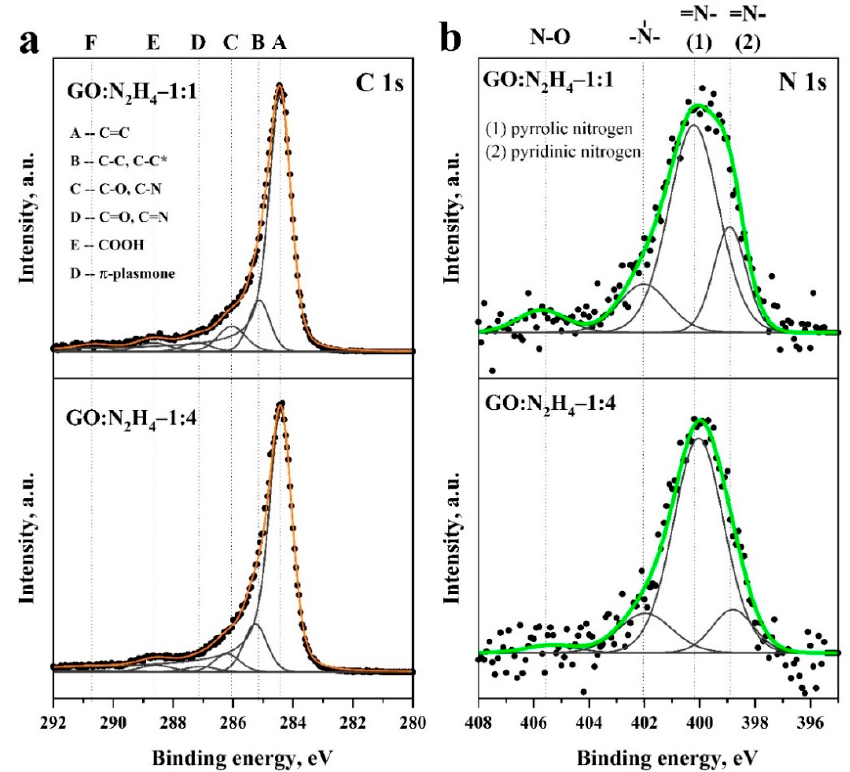
Figure 4. Detailed XPS C1s ( a ) and N1s ( b ) spectra of the samples GO:N 2 H 4 –1:1 and GO:N 2 H 4 –1:4 and associations relating to literature.